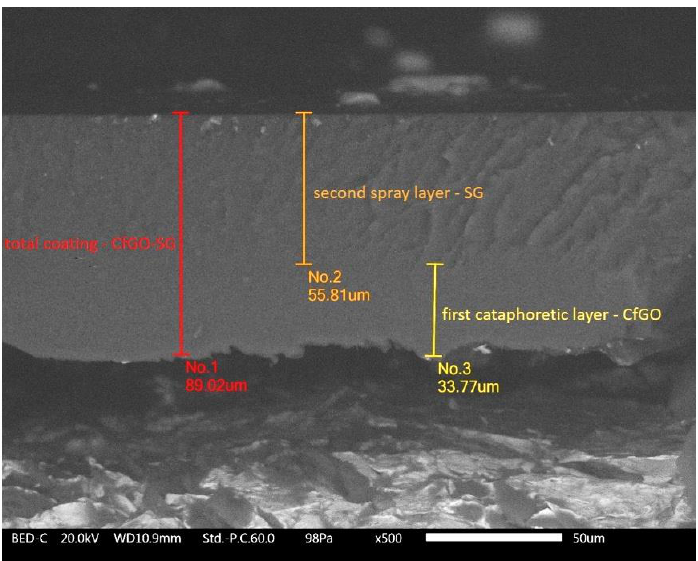
Figure 1. SEM micrograph of the cross section of coating CfGO-SG.